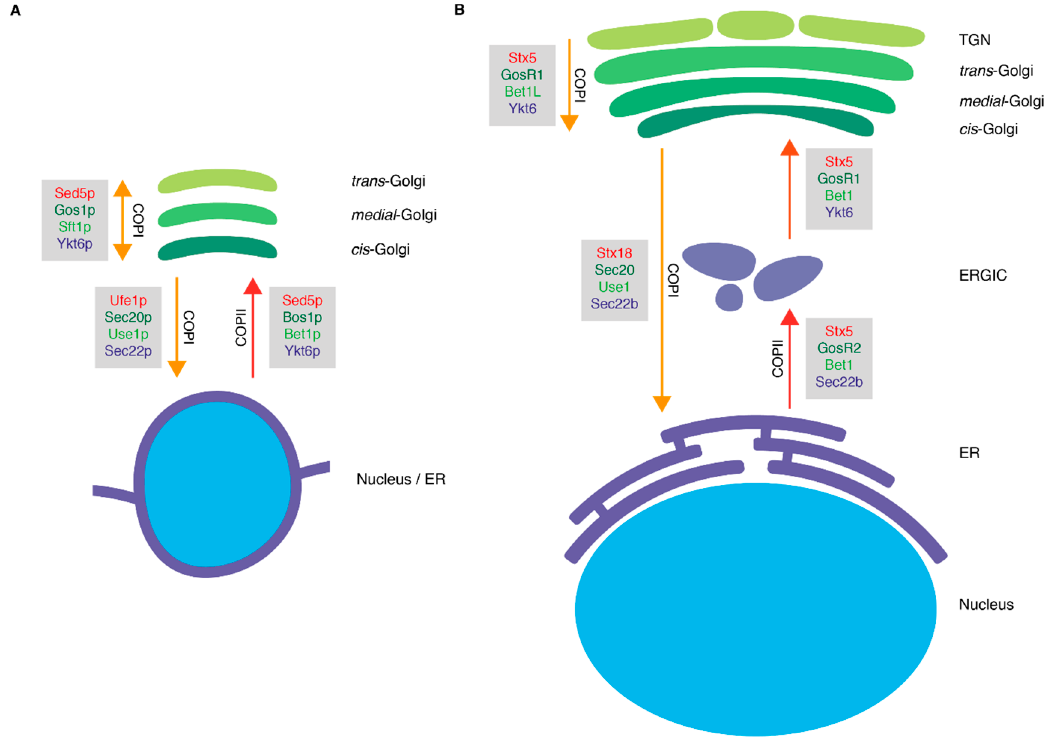
Figure 2. Schematic overview of SNARE complexes of the early secretory pathway in Saccharomyces cerevisiae ( A ) and mammalian cells ( B ). The grey boxes indicate the known SNARE complexes and their location along the secretory pathway. Colors of the SNAREs: red, Qa-SNAREs; dark green, Qb-SNAREs; light green, Qc-SNAREs; blue, R-SNAREs. Abbreviations: ER, endoplasmic reticulum; ERGIC, endoplasmic reticulum-Golgi intermediate compartment; TGN, trans -Golgi network.